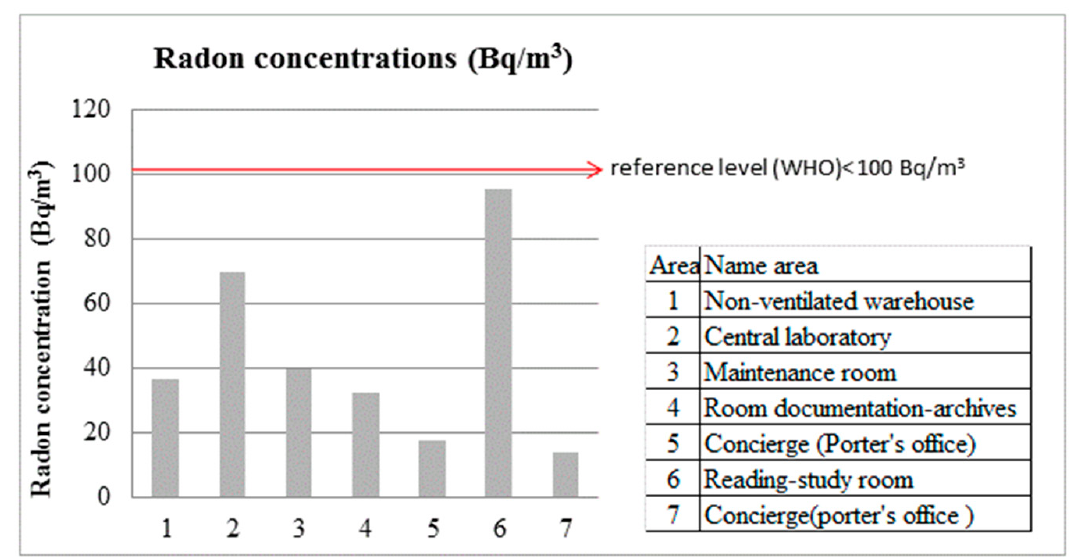
Figure 1. Mean indoor air radon concentrations at University of Granada (Southern Spain).